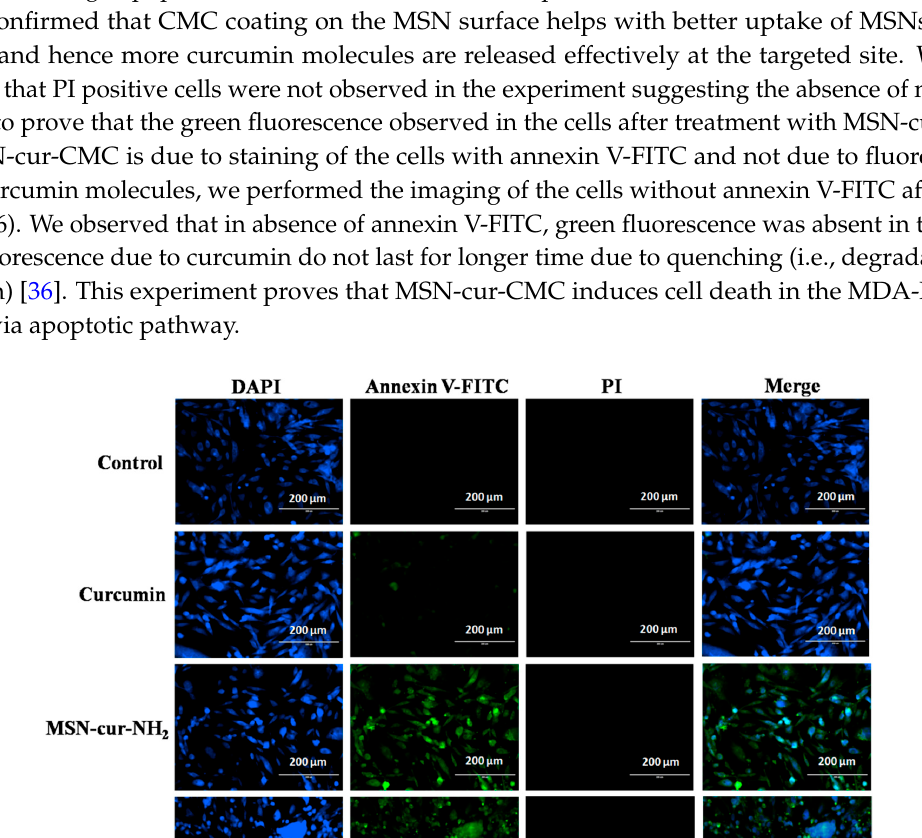
2 and MSN-cur-CMC in 48